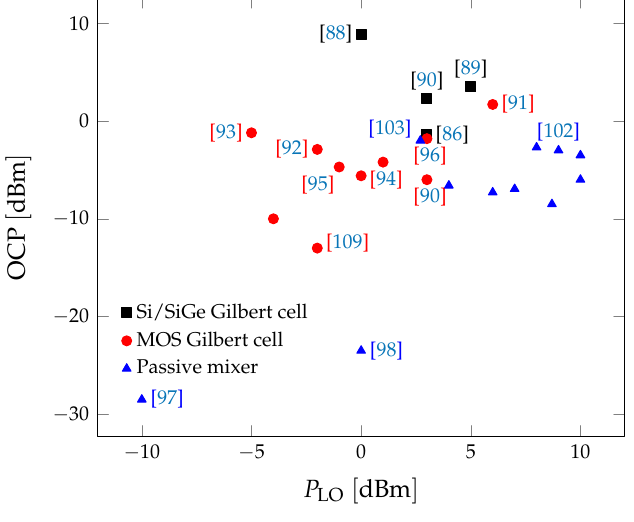
Figure 22. OCP versus P LO . The LO feedthrough is another widely shared data, allowing comparison of LO-to- RF isolation between mixers. Published data in the 10–140 GHz range are reported in Figure 23. Single-balanced (SB) papers are separated from double-balanced (DB) ones and from Gilbert cell derivatives using special feedthrough reduction techniques